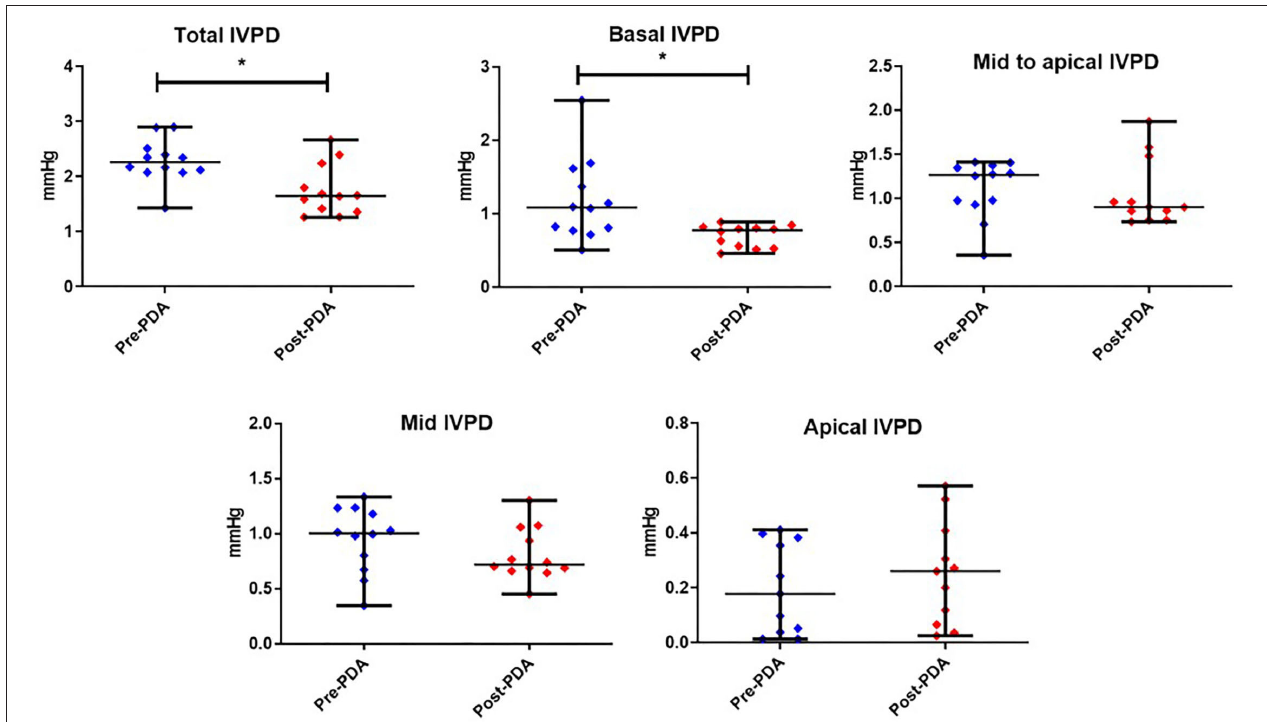
FIGURE 3 | CMME-derived intraventricular pressure difference (IVPD) variables before and after occlusion of the patent ductus arteriosus (pre-PDA, post-PDA) in dogs ( n = 12). Dots plots showing the median and range. *indicates the statistical significance ( P <